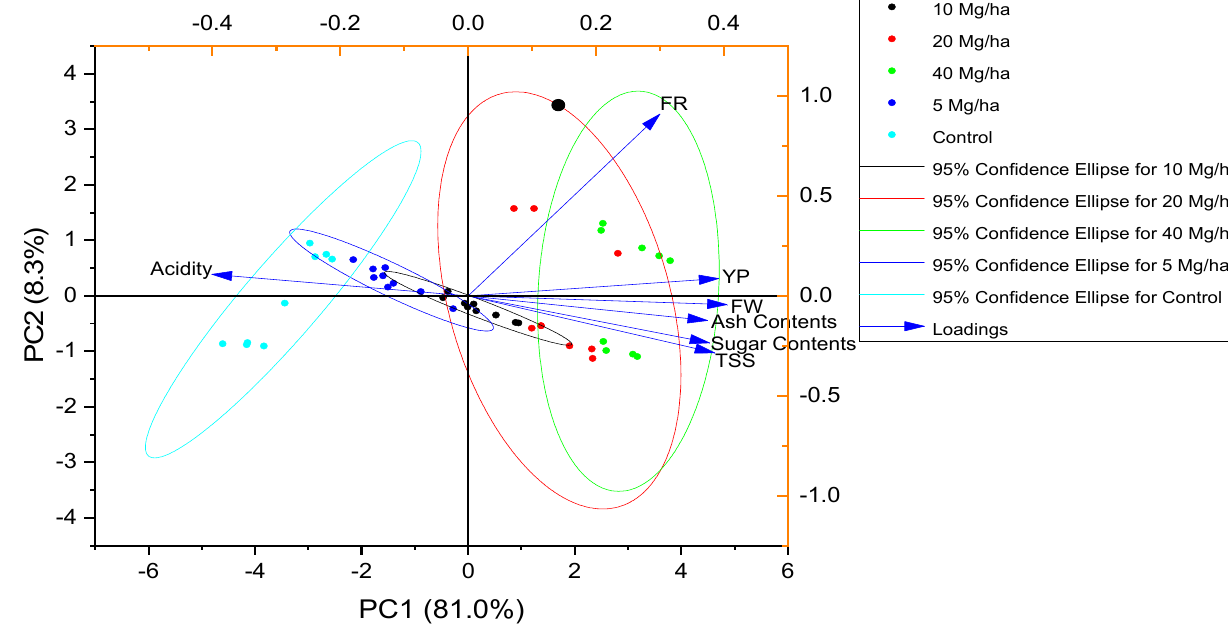
Figure 10. Principal component analysis for observed attributes of mango affected by different biochar application rates.